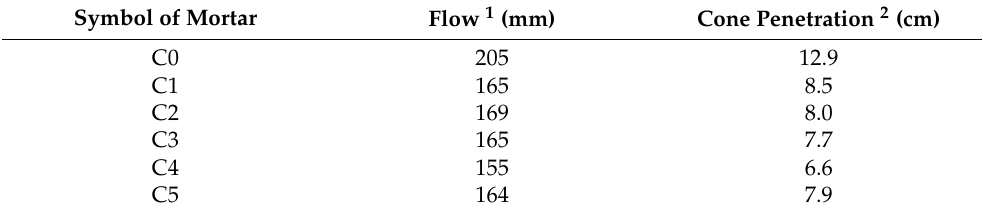
Table 4. Consistency results for all